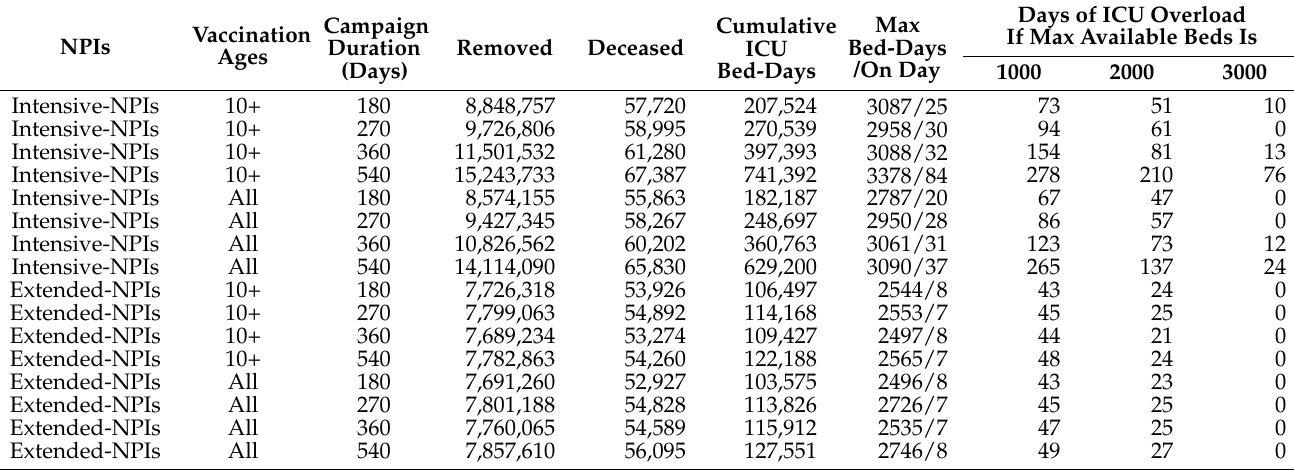
Table 4. Results of a vaccine with 75% transmission reduction, with the historical strain and Alpha variant under different vaccination ages, campaign duration, and non-pharmaceutical interventions (NPIs). Cumulative numbers of individuals